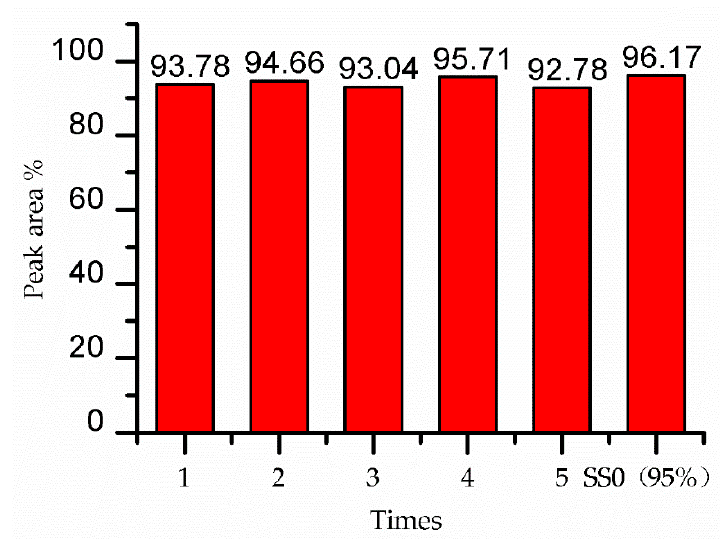
Figure 14. Percentage of solanesol peak area in desorption solution.